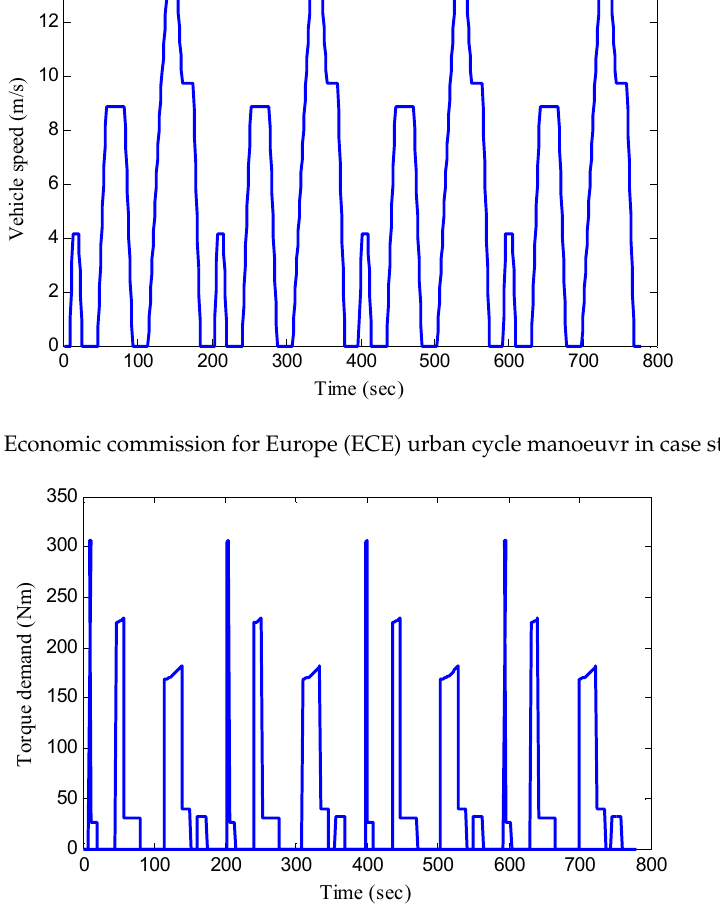
Figure 20. Torque demand in case study 3. World Electric Vehicle Journal 2019 , 10 , 15